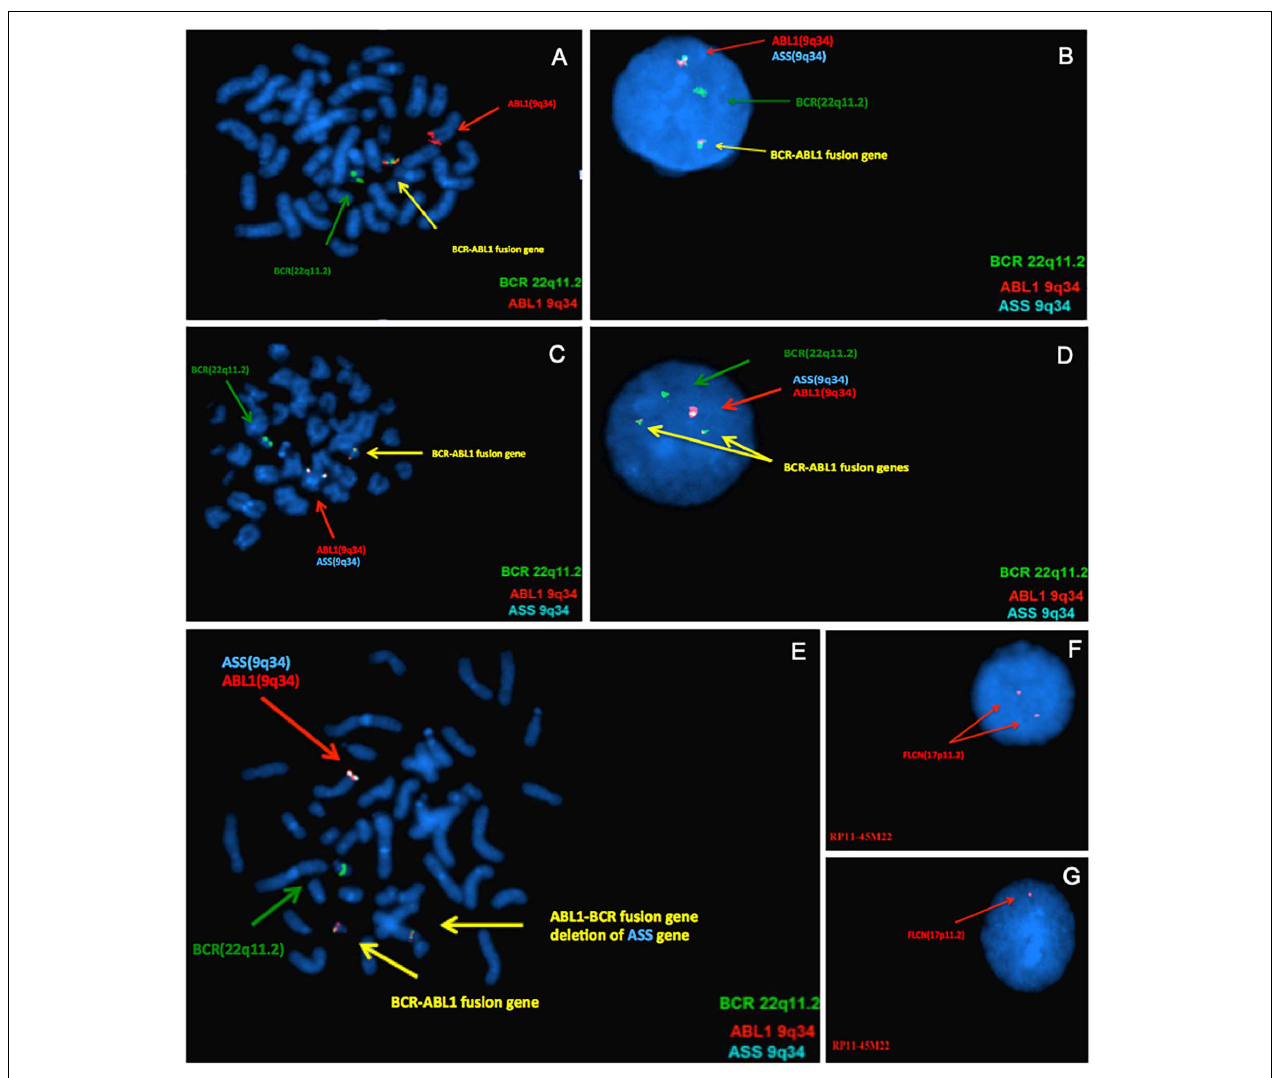
FIGURE 1 | Results of confirmatory Fluorescence in situ hybridization (FISH) analyses. From panels (A–E) , the green signal represents BCR gene on 22q11.2, the red and aqua signals on 9q34 represent ABL1 and ASS gene, respectively. The yellow signal represents BCR-ABL fusion gene. (A) FISH analysis using metaphase of case 3 confirmed the array-CGH finding, it had only one yellow fusion signal on der(22) and deletion of ABL-BCR fusion gene on der(9). (B) FISH test using DNA probes specific for BCR-ABL fusion gene of Case 8, indicate that one of the fusion gene ABL-BCR on der(9) was deleted. Only one ASS signal (aqua) can be seen, indicating ASS1 gene deleted. (C) Metaphase of Case 8. (D) This result confirms the deletion of 9q34 on the ASS gene of Case 10, which is associated with the disease. (E) Metaphase of Case 10. As for panels (F,G) , the FLCN gene located at chromosome 17p11.2. In Case 6, the FISH analysis showed normal hybridization signal patterns in the interphase (F) and one FLCN gene deletion in the interphase (G)